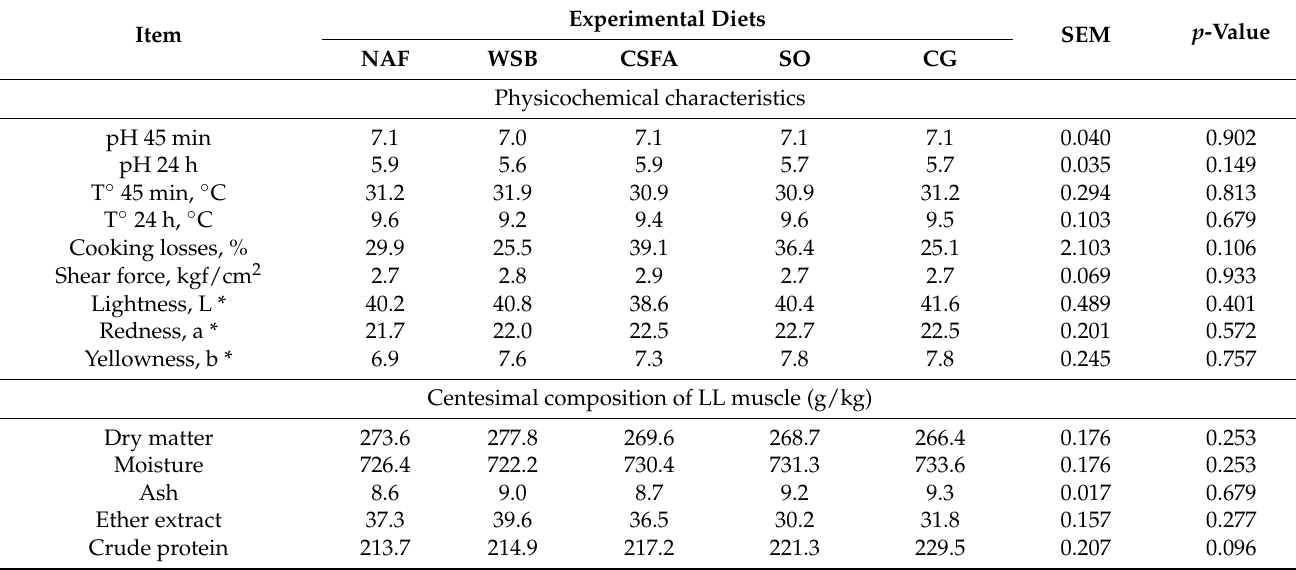
Table 5. Physicochemical characteristics and centesimal composition of the longissimus lumborum (LL) muscle of lambs fed diets containing different fat